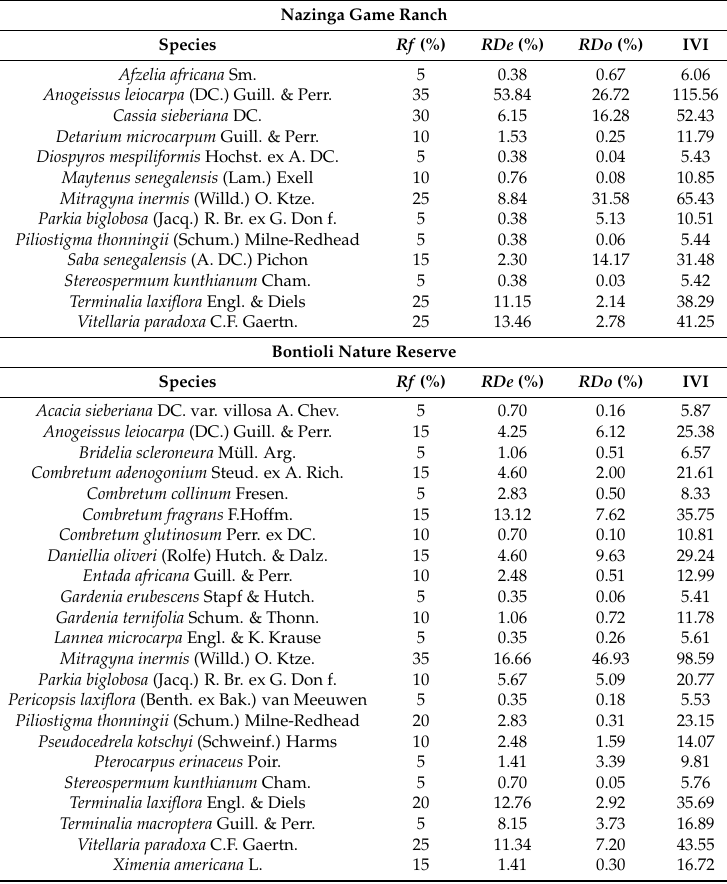
Table A2. Importance Value Index (IVI) of tree species at Nazinga Game Ranch and Bontioli Nature Reserve. Rf (%) is the relative frequency of tree species, RDe (%) is the relative density of trees species, and RDo (%) is the relative basal area of the tree species.